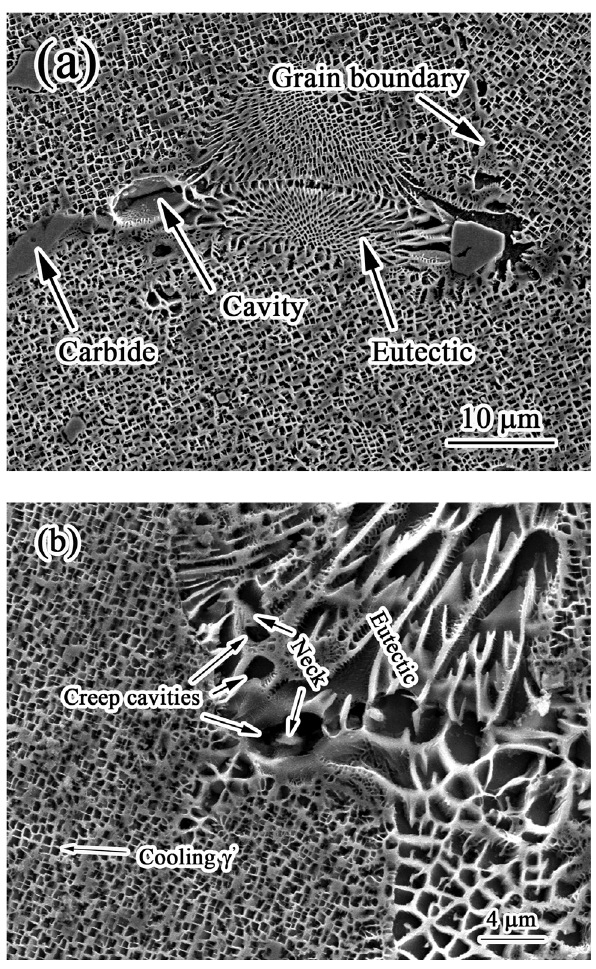
Figure 6: Microstructure characteristics of different HIP samples.